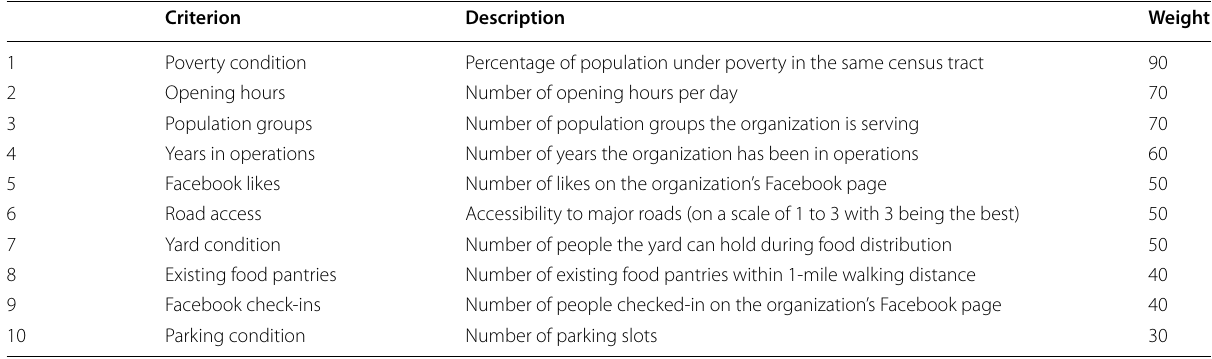
Table 1 The description and weight of the criteria